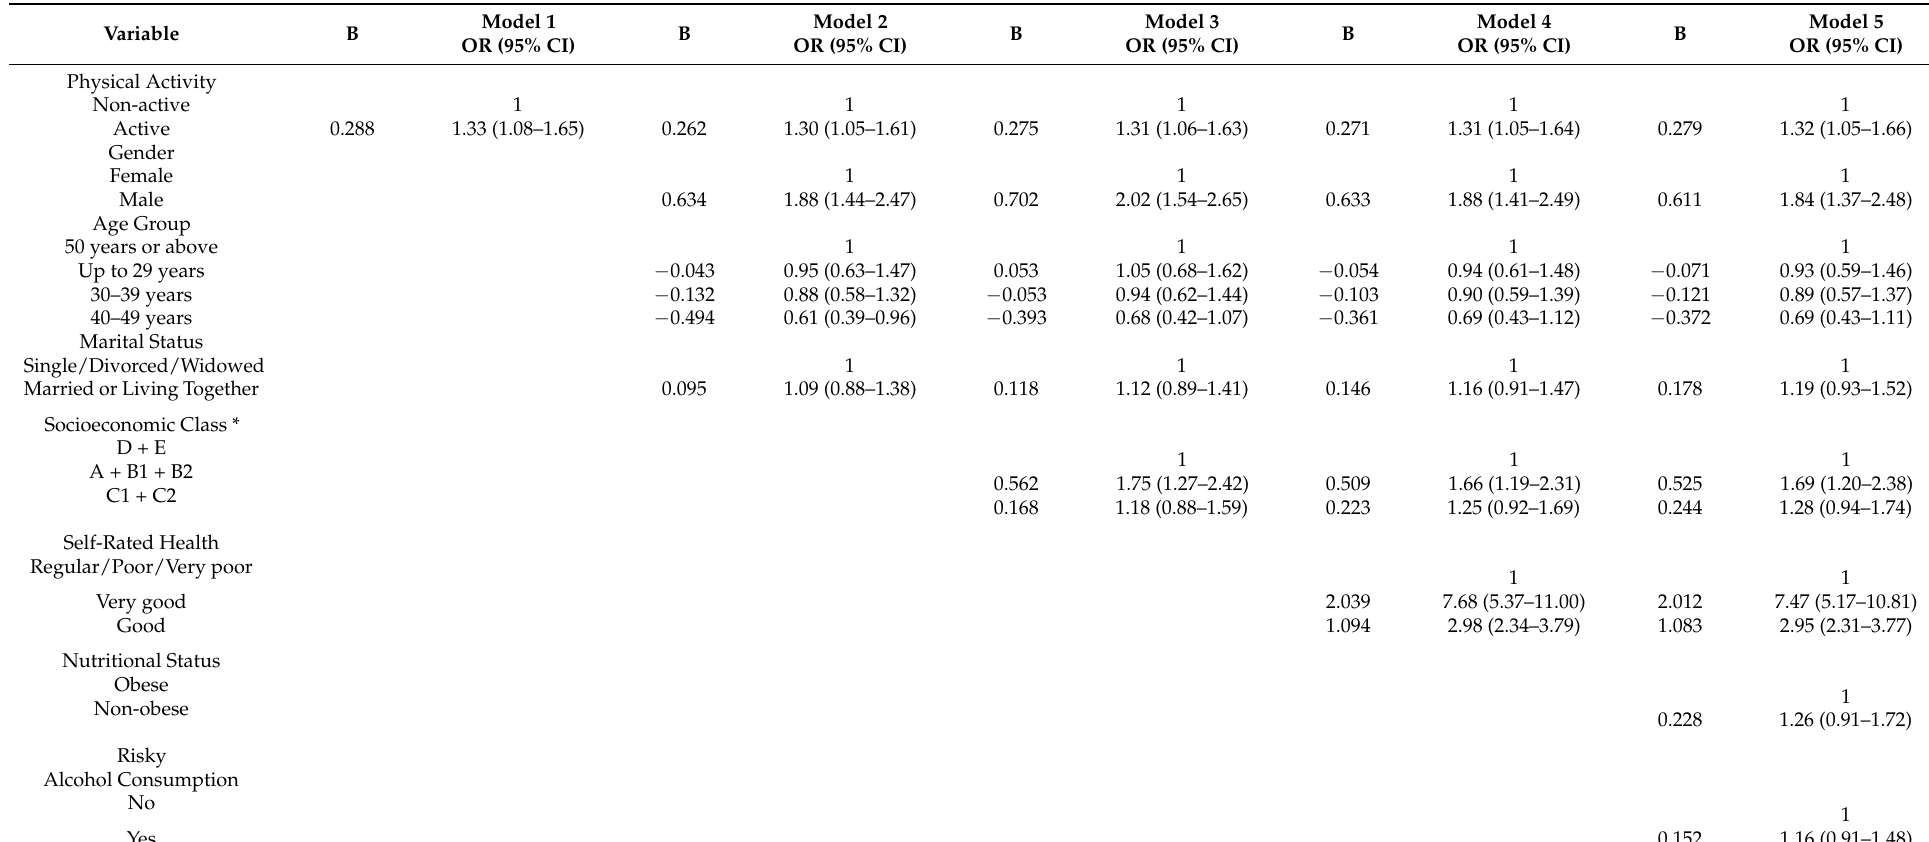
Table 4. Association between quality of life and demographic, socioeconomic, clinical, and behavioral